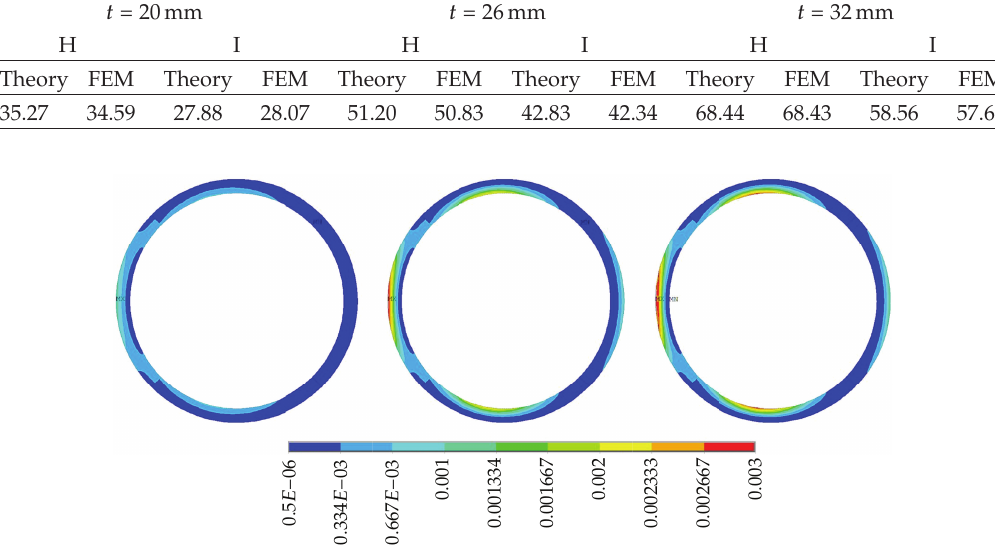
Figure 10: Evolution of the hoop strains at impending collapse (cid:6) p cr (cid:8) 42 . 34MPa (cid:7) from the FE analysis of a inhomogeneous ring (cid:6) t (cid:8) 26mm, D (cid:8) 457 . 2mm, ω (cid:8) 1 / 1000, n (cid:8) 3, and θ c (cid:8) π/ 4 (cid:7)